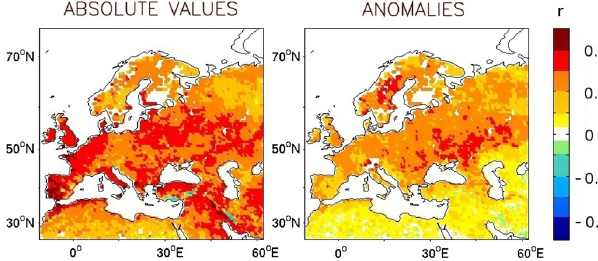
Figure 3. Comparison between the detrended ESA-CCI SSM and the detrended SSM simulated by ISBA-A-gs over the 1991–2008 period: Pearson correlation coefficient for (left) absolute values, (right) scaled anomalies (Eq. 1). White areas over land correspond to r values lower (higher) than 0.1 ( − 0.1).